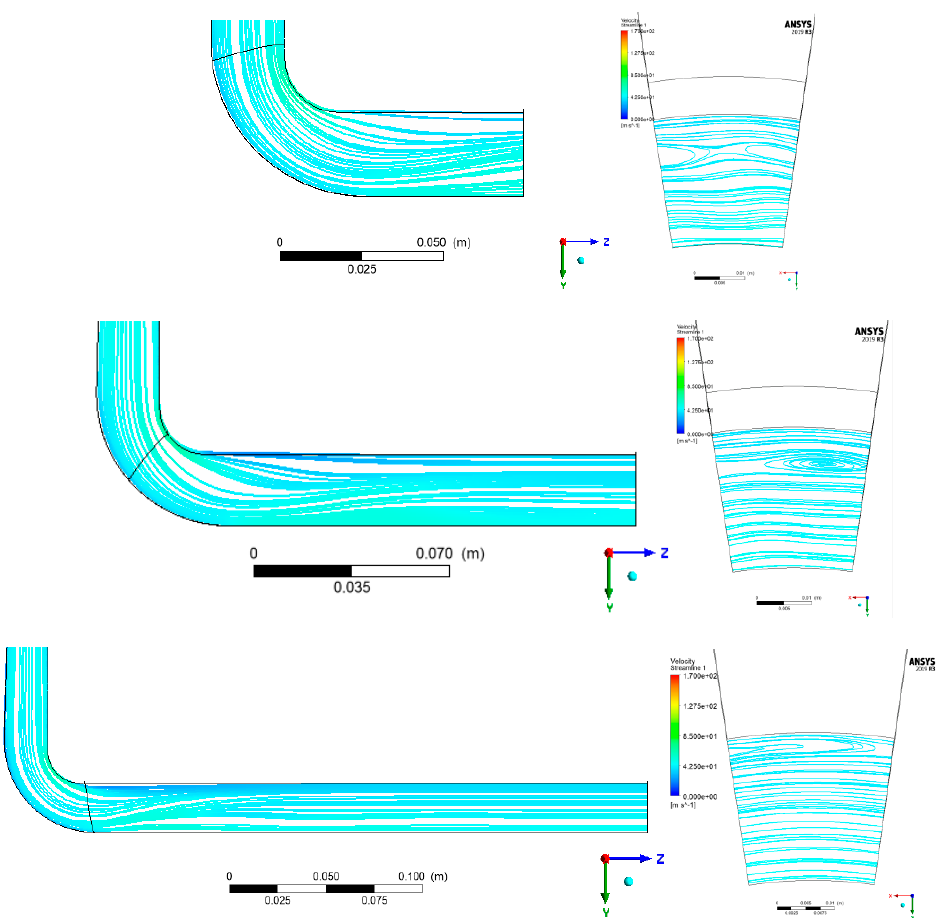
L R = ( above ), 3 L R = ( center ), 6 L R = ( below ). 1 6 h 1 6 h 2 6 h Velocity legend: from 0 to 170 m/s.